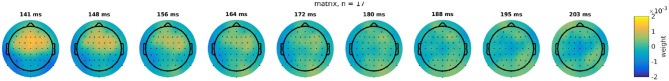
The topography of the movie condition using the Matrix data between 141 and 203 ms.